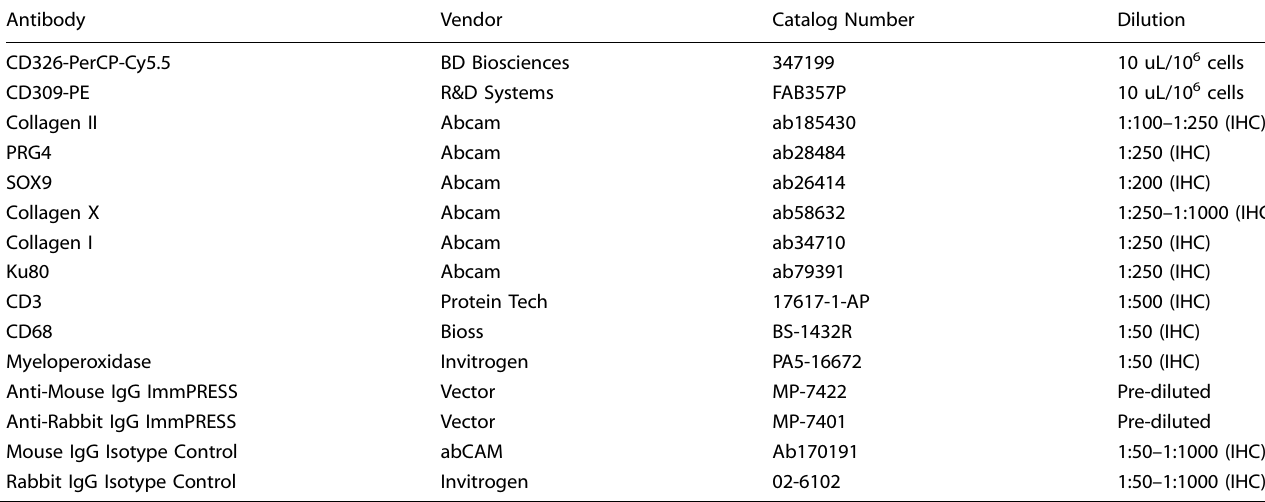
Table 2. Antibodies used in this